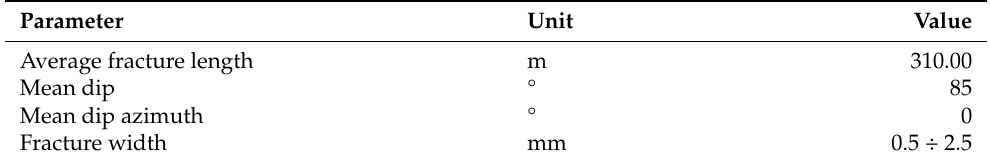
Table 1. Geometrical properties of the fractures used as an input to Petrel’s DFNs modelling tool [2].